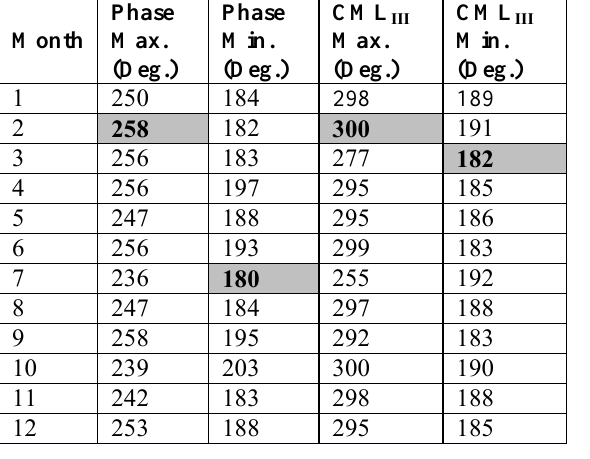
Table1: Io-A for year (2006). Table2: Io-B for year(2006).